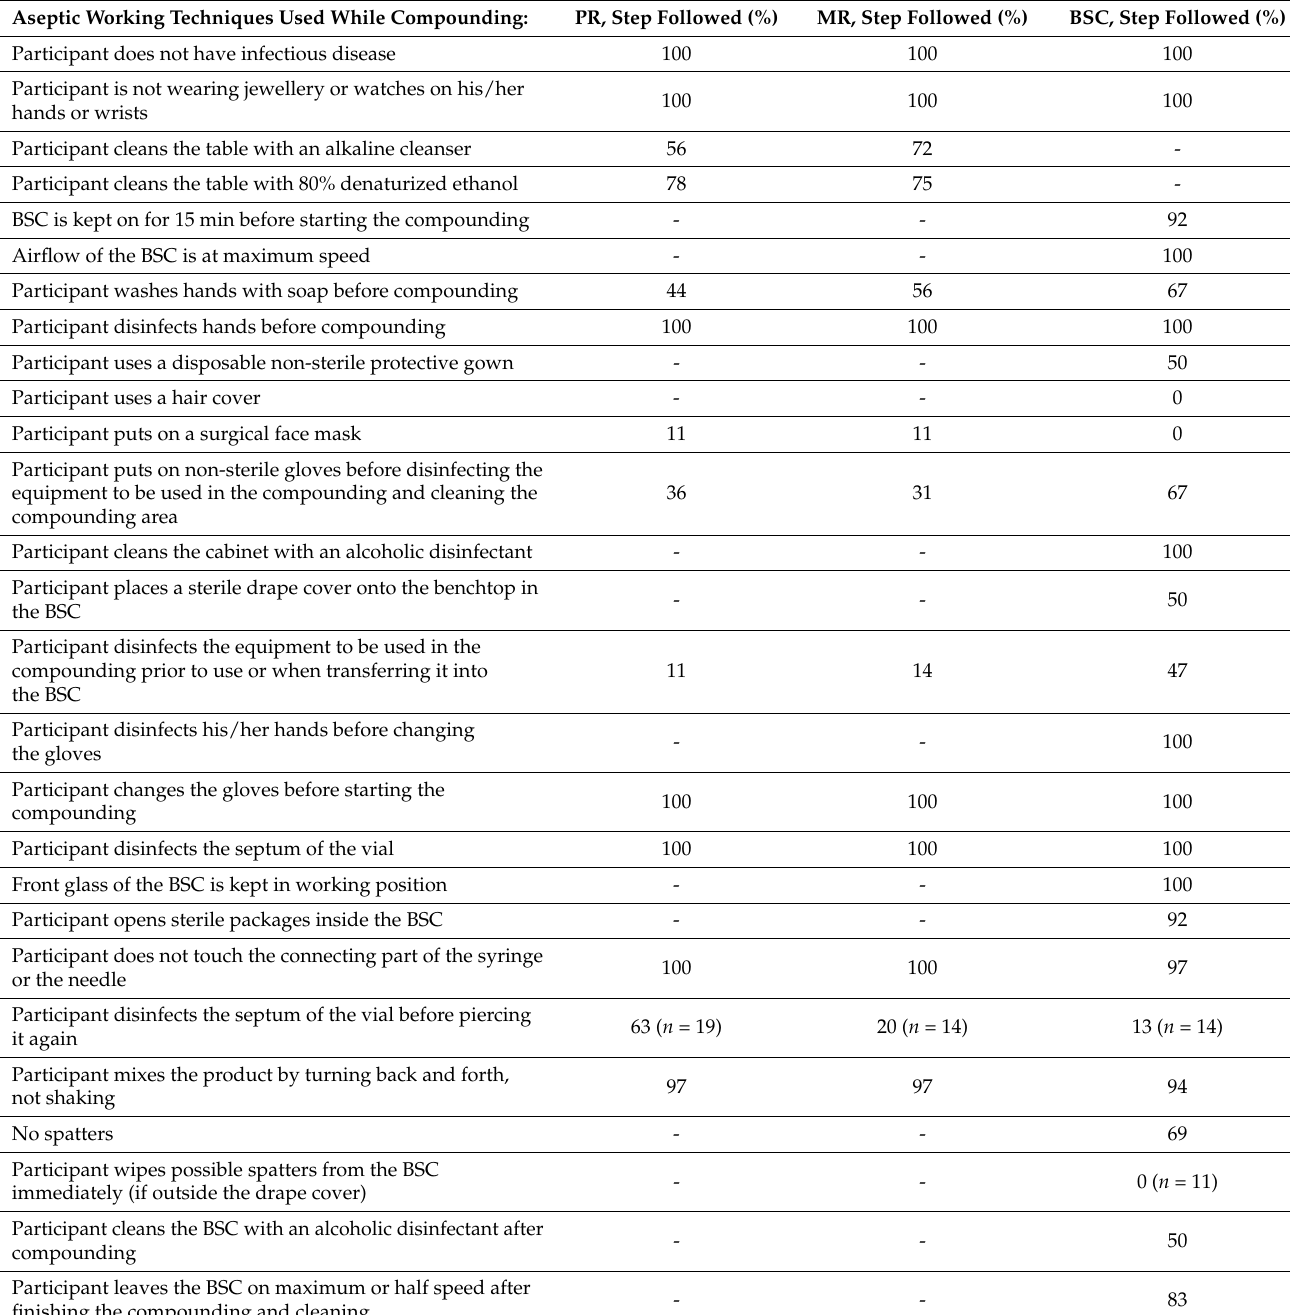
Table 1. Results from the observations made during compounding of parenteral product samples in three different environments in hospital wards: patient room (PR, N = 36), medicine room (MR, N = 36) and biological safety cabinet (BSC, N =